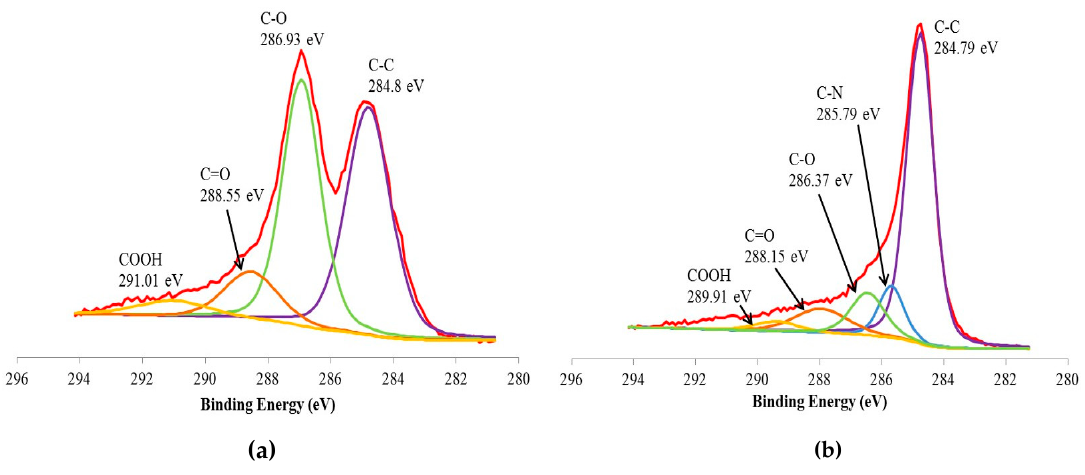
Figure 4. The C1s XPS spectrum of ( a ) GO; ( b ) RGO.